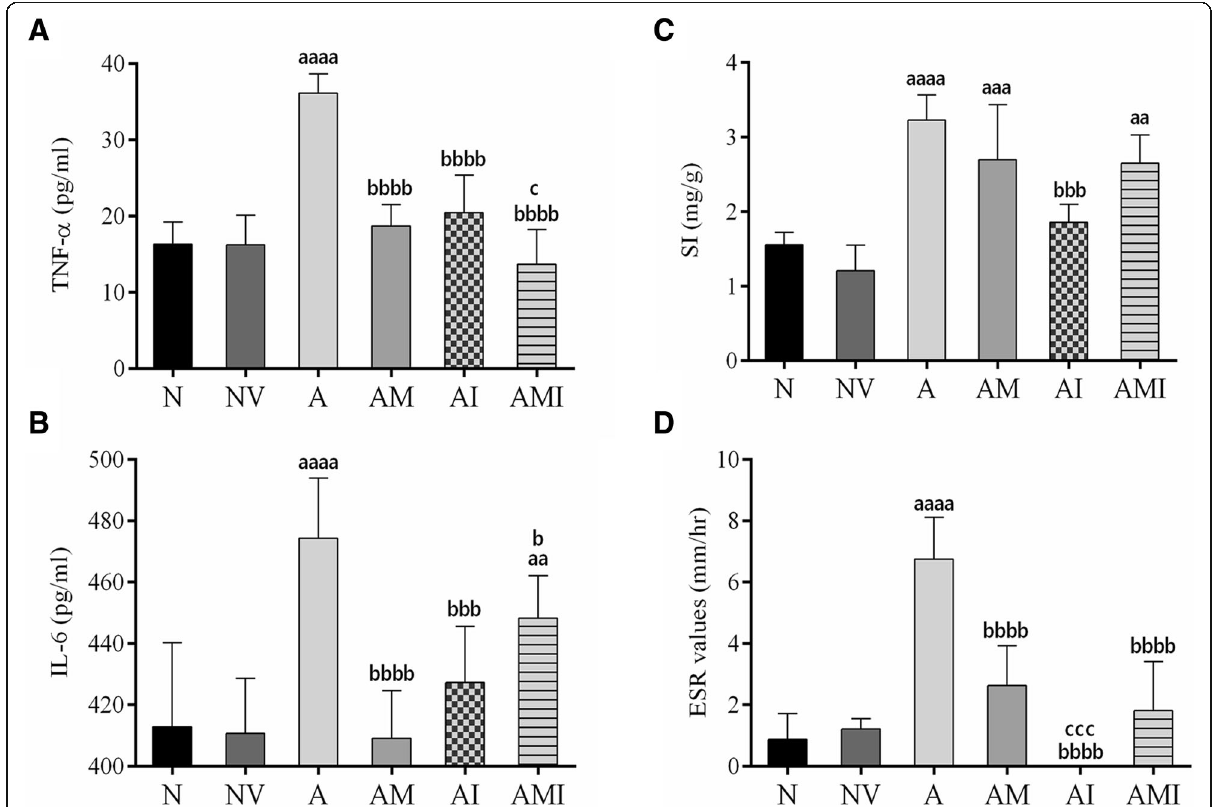
Fig. 3 Assessing effect of I3C on inflammatory markers on day 23 ( n =8). a Mean TNF- α values (pg/ml) in serum of rats. b Mean IL-6 values (pg/ml) in serum of rats. c Mean spleen index values (SI) (mg/g) of rats. d Mean erythrocyte sedimentation rate values (ESR) (mm/hr) of rats. aa p <0.01 aaa p <0.001 aaaa p <0.0001 compared with the normal group receiving the vehicle (there was no statistical significant difference between the two normal